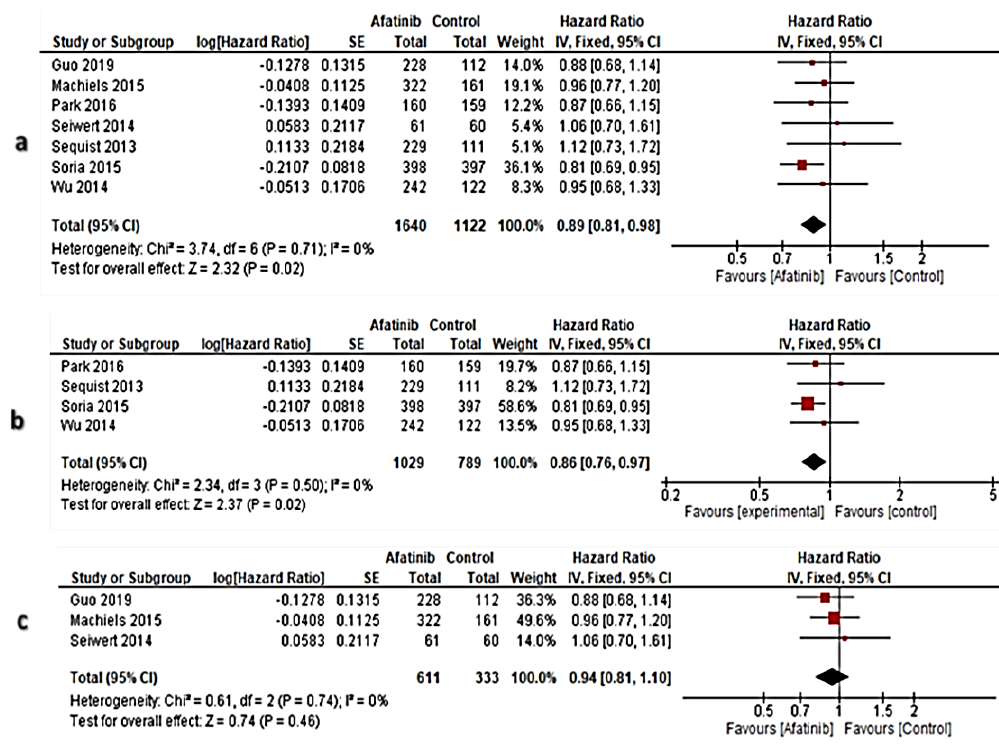
Figure 4. Forest plots of OS; ( a ): Subset of OS in all RCTs, ( b ): The subset of OS in NSCLC, ( c ): subset of OS in HNSCC. Fixed effect model of meta-analysis has proceeded. Red color is the CenterPoint of the confidence interval expressing the weight of the sample size in each RCT, while black-colored diamond denoted the overall effect